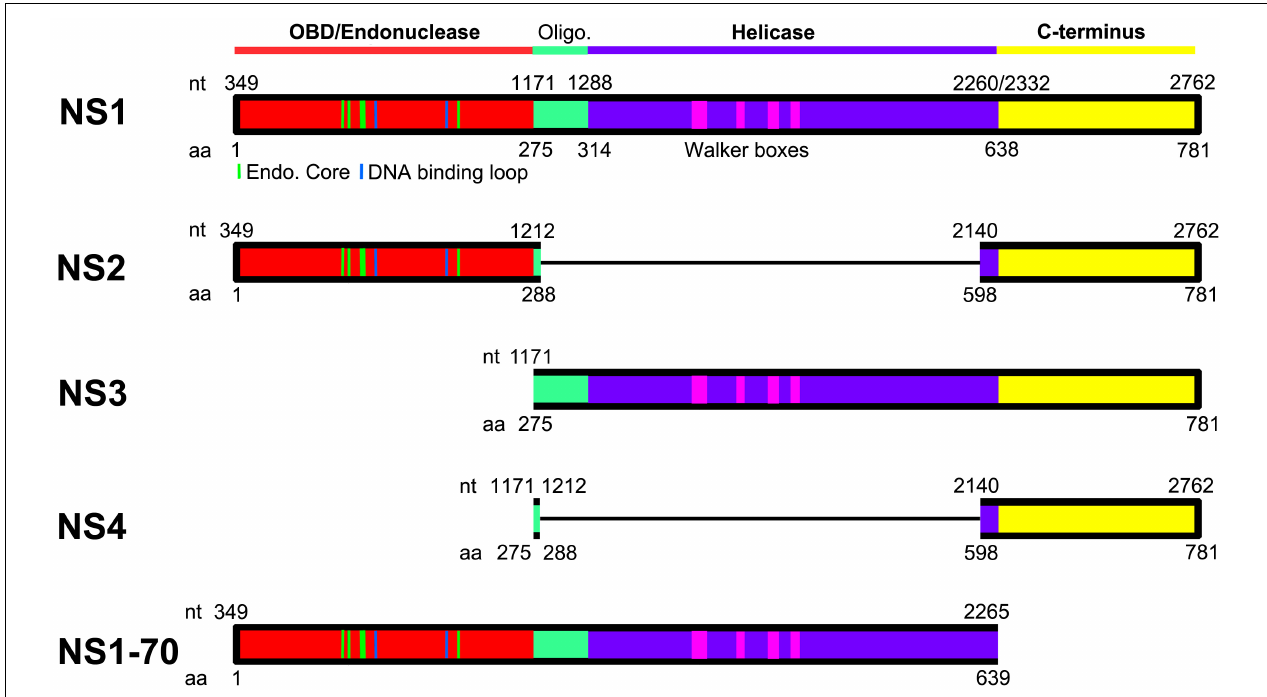
FIGURE 4 | Domains of HBoV1 NS proteins. HBoV1 NS1 (GenBank: AFR53039) and AAV5 Rep78 (GenBank: AAD13755) are aligned. N-terminal origin DNA binding domain (OBD; in red) and helicase domain (in purple) are diagramed. The regions positioned between the OBD and helicase domains (shown in green) are predicted to be the oligomerization signal. The C-terminal region (shown in yellow) is predicted to serve potentially transcriptional activation function. Dashed lines in the OBD indicate residues that are structured as endonuclease core/DNA binding loop (Tewary et al., 2013), and dashed rectangles in the helicase domain indicate Walker boxes (Koonin, 1993). Oligo. indicates a putative oligomerization signal. NS2, NS3, NS4, and NS1-70 proteins are diagramed in colored blocks with thin lines indicating excised aa sequences due to ligation of the neighboring exons of their